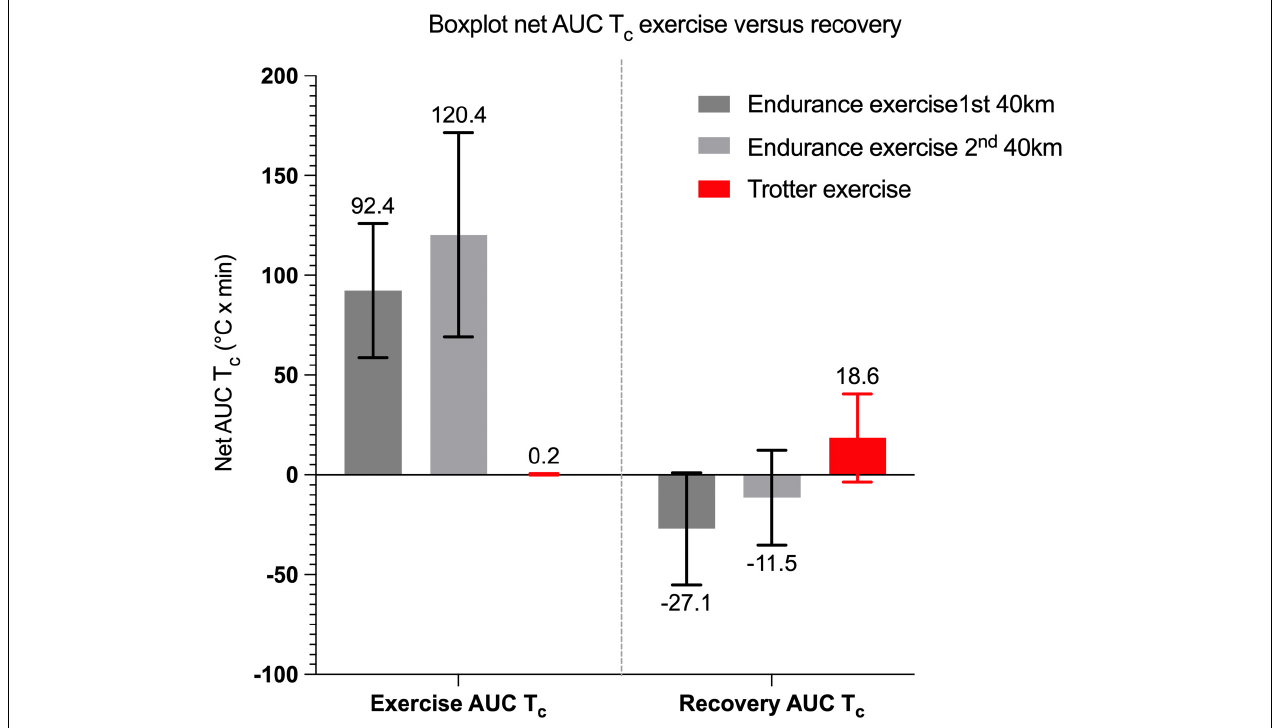
FIGURE 6 | Boxplot of the dynamic thermal response presented by net AUC T c ( ◦ C × min) during T c exercise period of endurance and trotter exercises (presented with mean net AUC on top bar). The 1 st 40 km of endurance exercise was not significantly different to the 2 nd 40 km. Net AUC T c of exercise and recovery from full speed trotter exercise over 1,540 m was minor during exercise while T c increased post-exercise as represented by positive net AUC T c